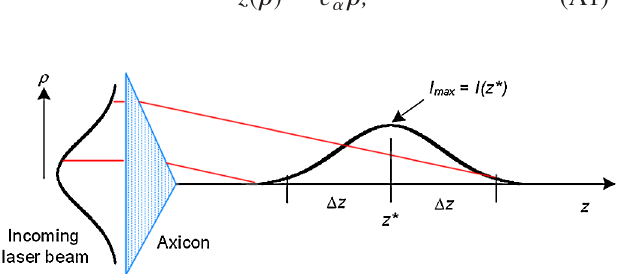
FIG. 11. Mapping of Gaussian-shaped incoming laser beam onto axicon focal